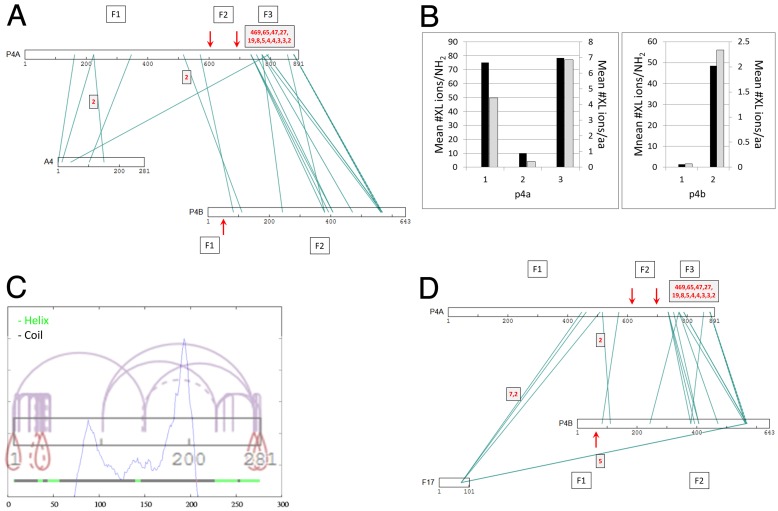
(a) XL interactions between the three major structural proteins p4a, p4b and A4 (p39). F1, F2, F3 (boxed): fragments 1, 2 and 3 of p4a, and fragments 1 and 2 of p4b generated during virion maturation by AG|-specific processing after p4a residues 614 and 697 [139] and p4b residue 61 [140] (red vertical arrows). (b) Mean # of XL ions (intra- and inter-molecular) detected per amino group (lysine sidechain and fragment N-terminus; Y1 axis, black bars) and per residue (Y2 axis, gray bars) in fragments 1, 2 and 3 of p4a (left), and fragments 1 and 2 of p4b (right), as generated by AG|-specific processing at the sites indicated in panel A. Raw numbers are given in Table C in S1 Text. (c) Predicted three-domain structure for protein A4. Lower horizontal line: Predicted helix (green) and coil (black). Blue trace: Predicted domain boundaries at residues 88 and 193 based on an endpoint density profile from 2718 PSIBLAST hits. Mauve: Intra-A4 XL. The density of XL within N- and C-terminal regions is consistent with the presence of discrete N- and C-terminal domains coincident with the green helical regions. XL from both protein termini to positions 100 and 150 (towards the N- and C-terminal ends, respectively of the short central domain located between residues 88 and 193) suggest that the central region of A4 is within crosslinking range of the two terminal domains. (d) XL interactions of structural proteins p4a and p4b with protein F17. Vertical red arrows: As in panel A. In panels A, D: Numbers (red font) in gray squares with black border: DFscore (XL with no red-font numbers had a DF score of 1).